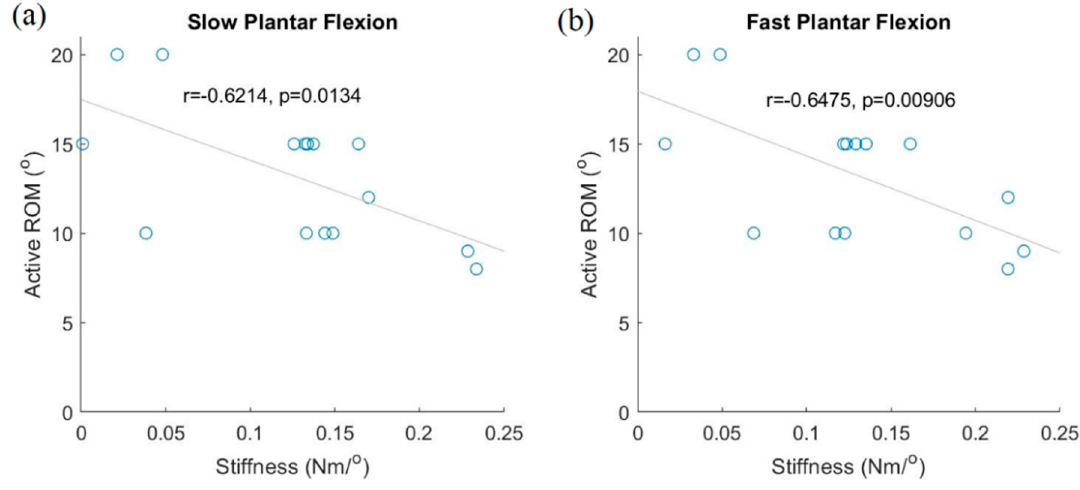
The ICC, 95% confidence interval, and limits of agreement of ankle stiffness between visits 1 and 2 are shown in Table 1. Bi-axial ankle stiffnesses showed significant reliability for slower movements, except for the stiffness around the designated everted-medial position during passive movement along the subtalar joint. When the ankle achieved the designated plantar flexion during slower movements, the stiffness along the talocrural joint showed a significantly negative correlation with the active ankle ROM (Figure 3, slower movement: r = − 0.621, p = 0.013; faster movement: r with stiffness along the talocrural joint for faster dorsiflexion movements, stiffness along the talocrural joint showed a significant positive correlation with active dorsiflexion ROM. When the ankle was in the designated eversion position during slower/faster movements, stiffness along the subtalar joint showed a significant negative correlation with active ankle ROM (slower movement: r = − 0.521, p = 0.046; faster movement: r = − 0.632, p = 0.011).